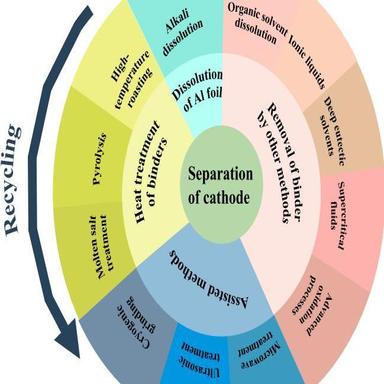
Detailed classification of current status for separation of cathode materials and Al foil.